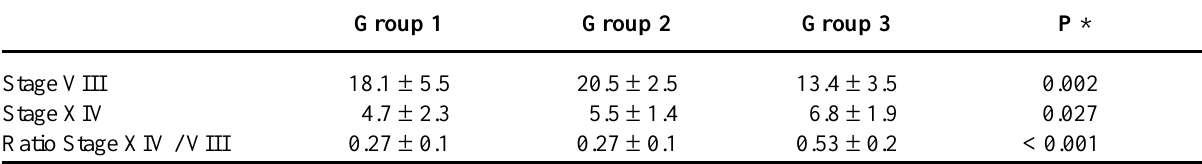
Table 2 – Frequencies and ratios of stages VIII and XIV of seminiferous epithelium in animals with CCl cirrhosis, food restriction and without food